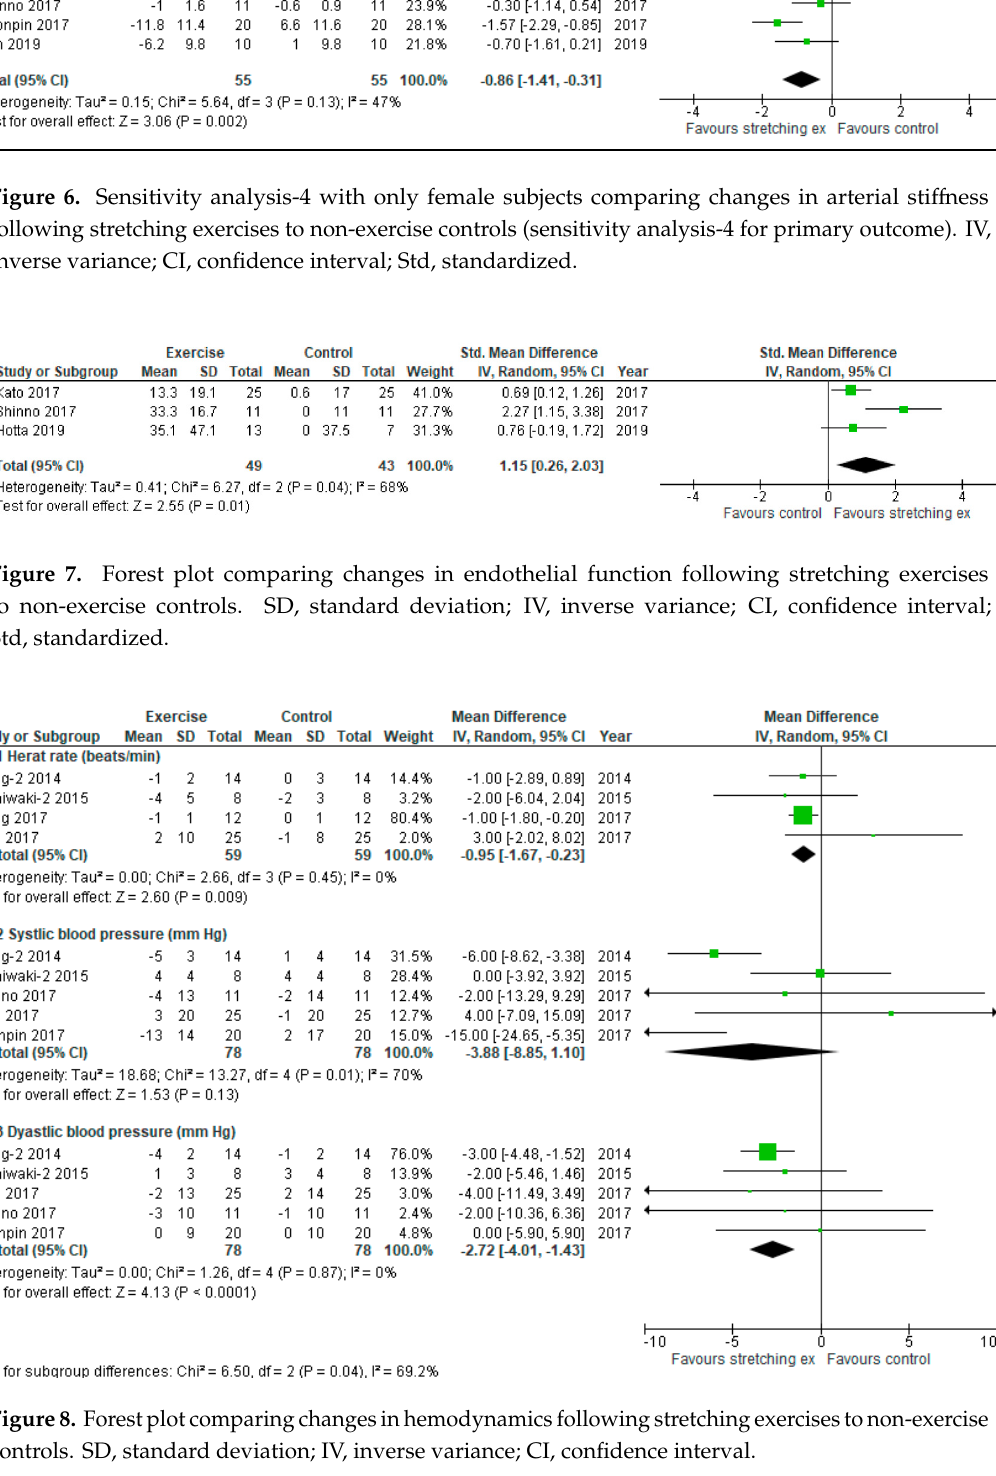
Figure 9. Forest plot comparing changes in muscle flexibility following stretching exercises to non-exercise controls. SD, standard deviation; IV, inverse variance; CI, confidence interval.